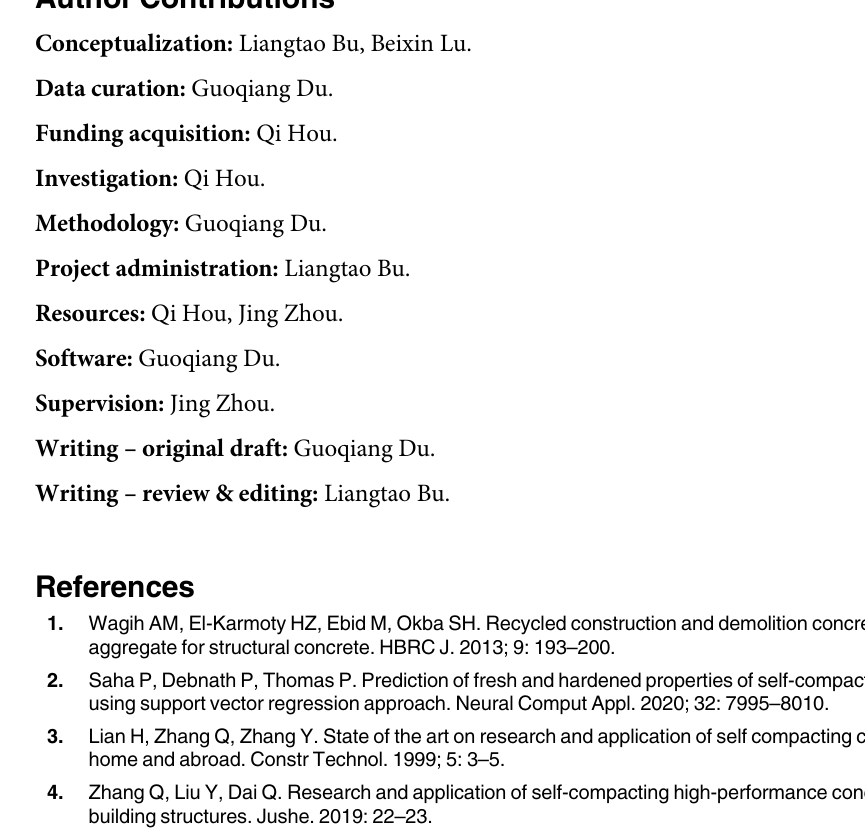
S1 Fig. Comparison of other empirical